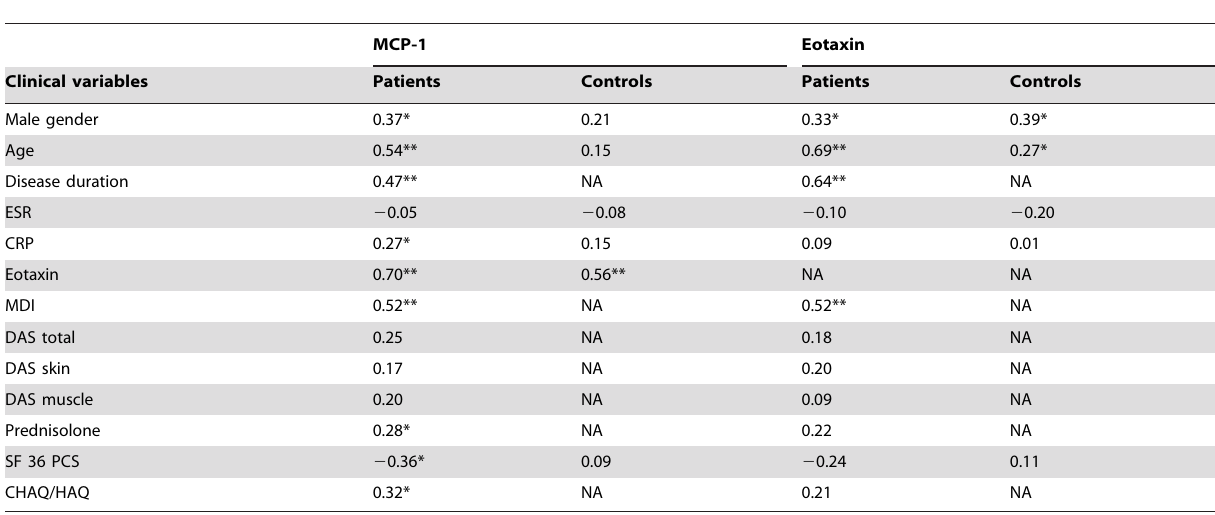
Table 3. Correlations between MCP-1, eotaxin and clinical and disease variables in patients with juvenile dermatomyositis assessed median 16.8 years after disease onset, and in controls.